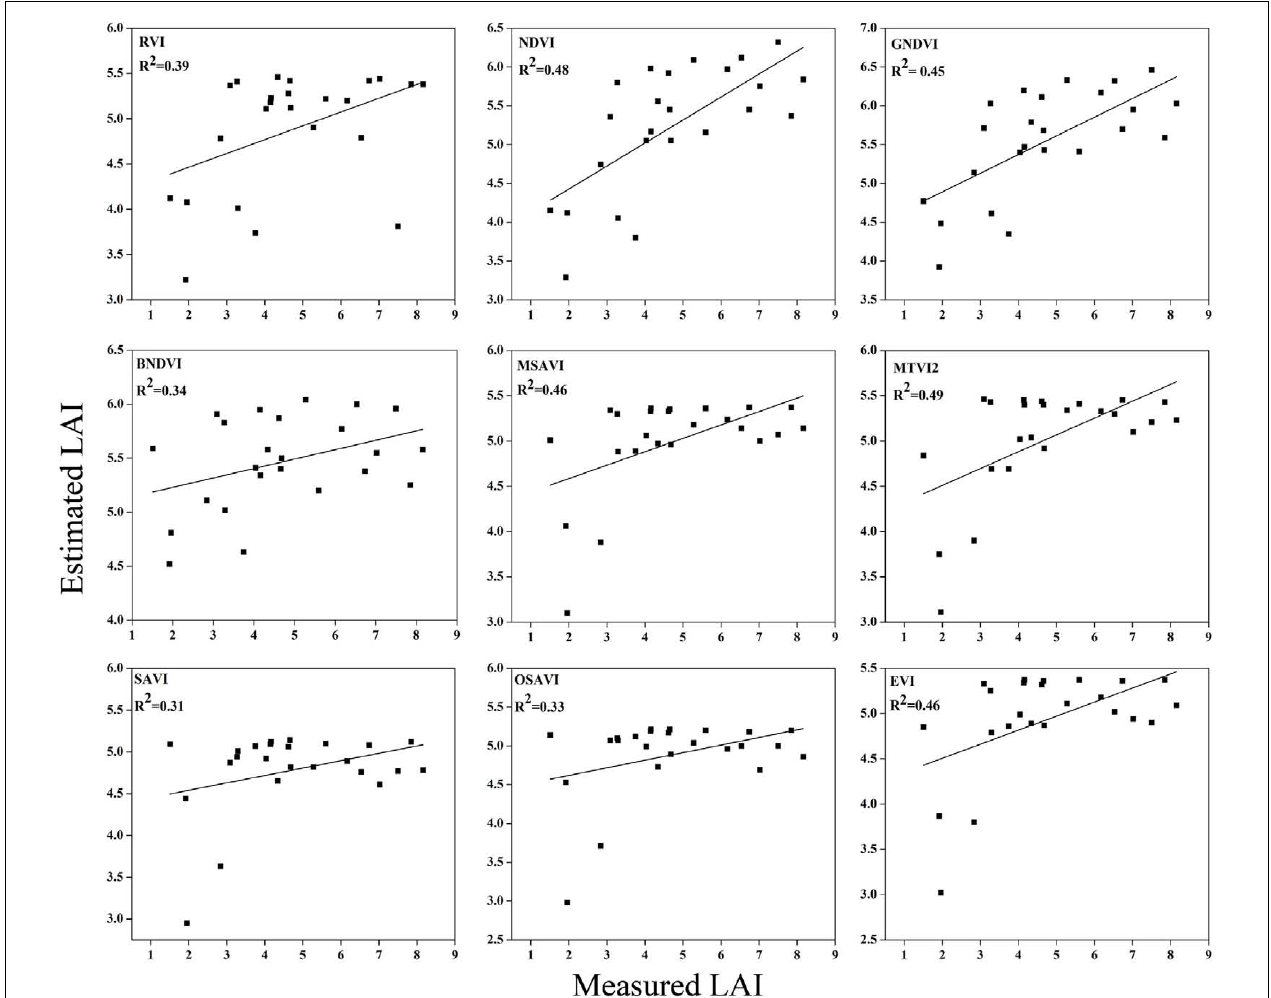
FIGURE 12 | Relationship between measured LAI and estimated LAI at